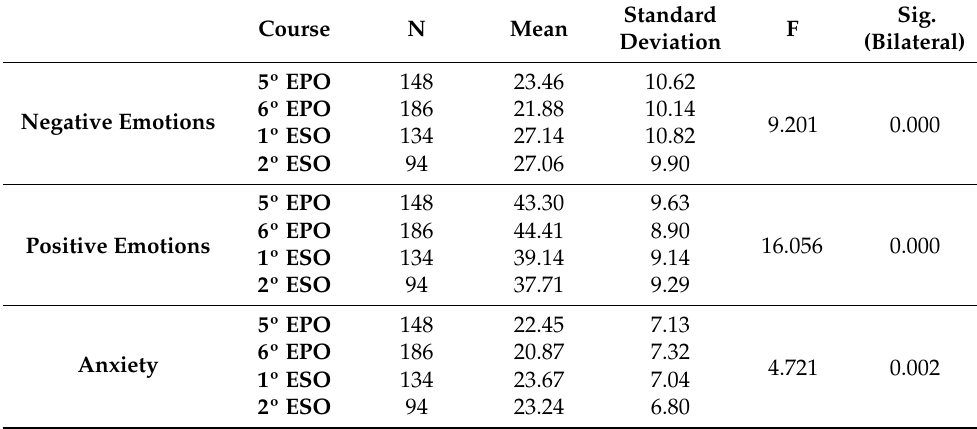
Table 6. Results of the ANOVA test between the EES and the academic year.